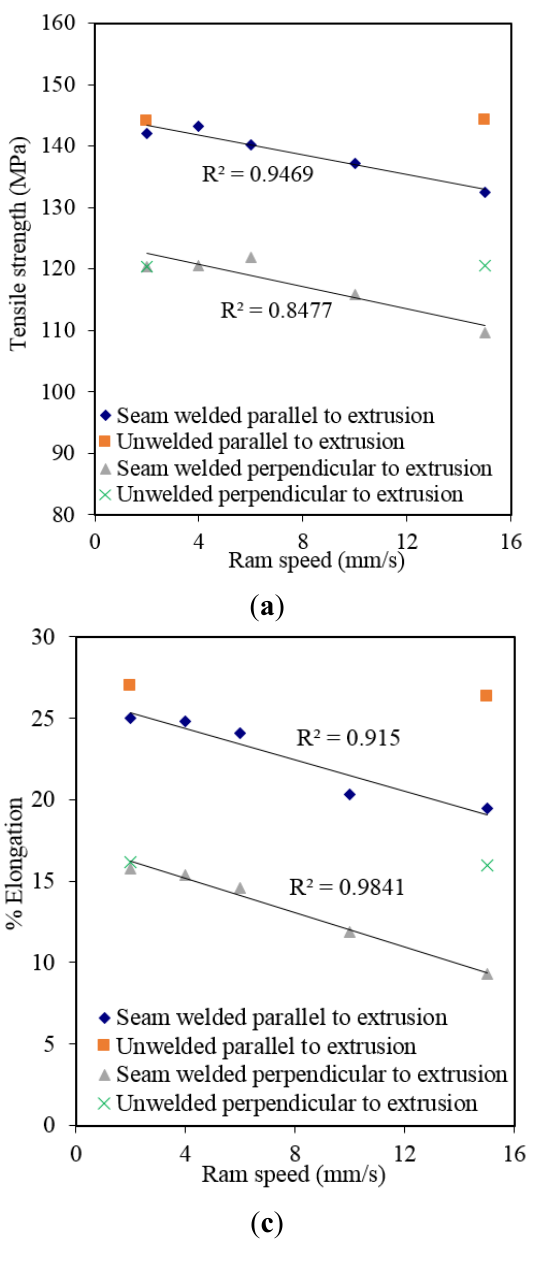
Figure 3. Effect of the ram speed on the specimens: ( a ) tensile strength; ( b ) yield strength; ( c ) %